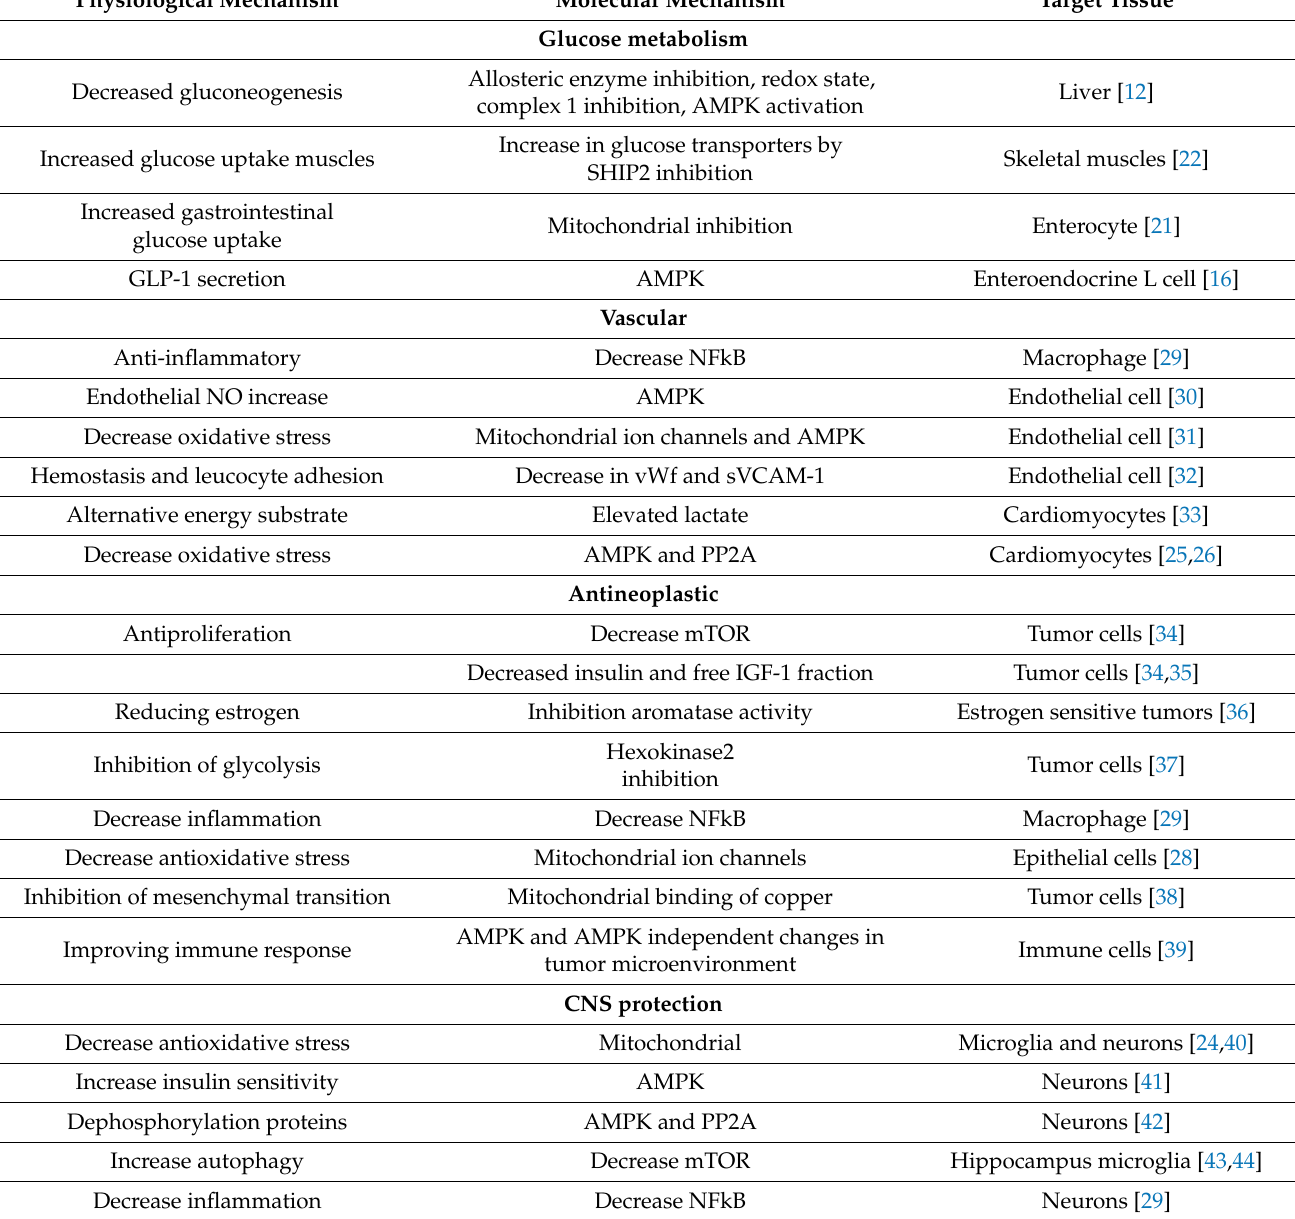
Table 1. Mode of action of metformin in various physiological